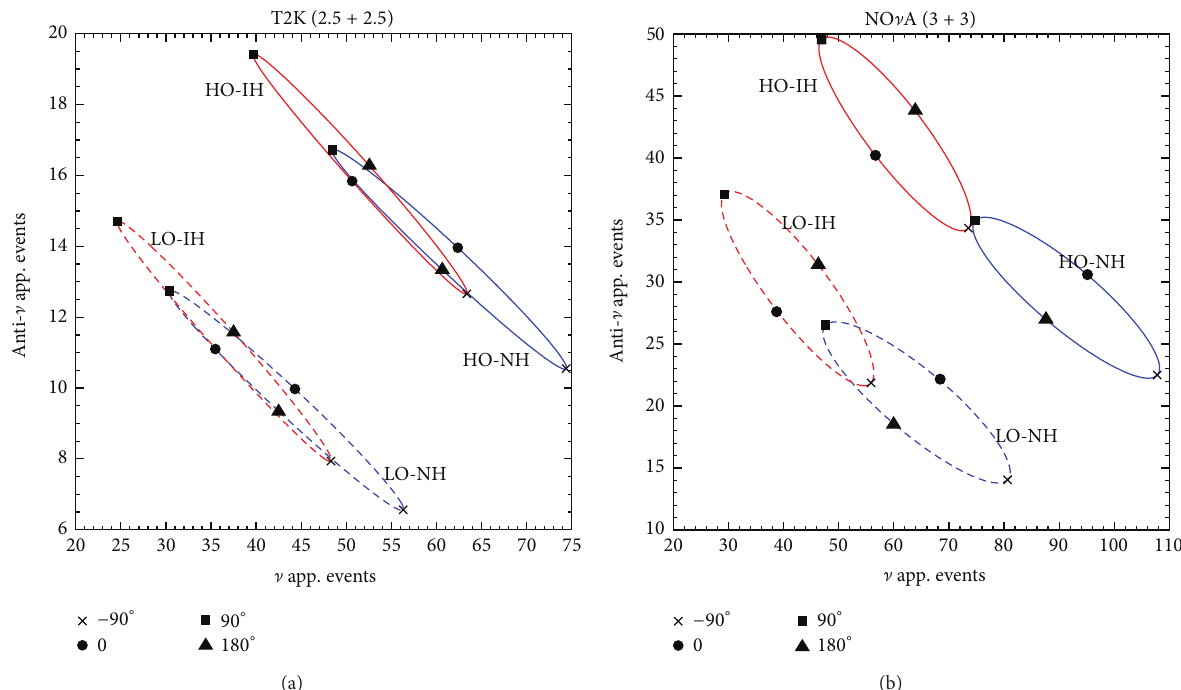
Figure 8: Neutrino and antineutrino appearance events for all possible combinations of hierarchy, octant, and 𝛿 for T2K (NO ] A). Here, sin 2 2𝜃 13 = 0.089 . For LO (HO), sin 2 𝜃 23 = 0.41 (0.59) . Note that for T2K, equal ] and ] runs of 2.5 years each have been assumed. This figure has been taken from [71].